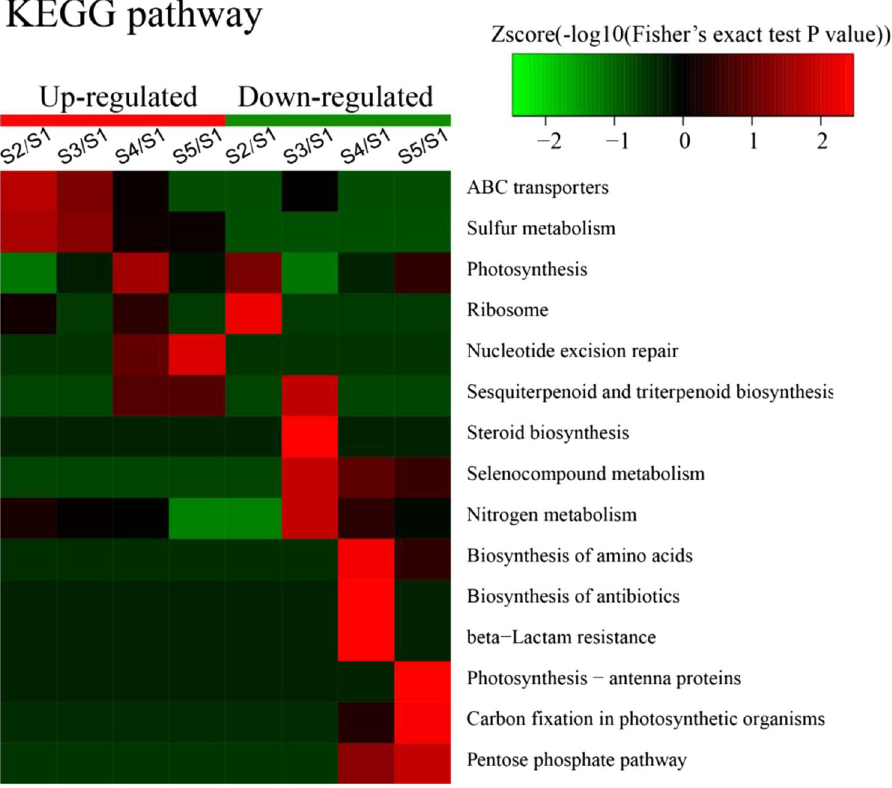
Figure 11. Heat maps obtained from GO enrichment-based cluster analysis of KEGG pathways. Control sample (S1); sample treated with PG for 12 h (S2), 24 h (S3), 48 h (S4), 72 h